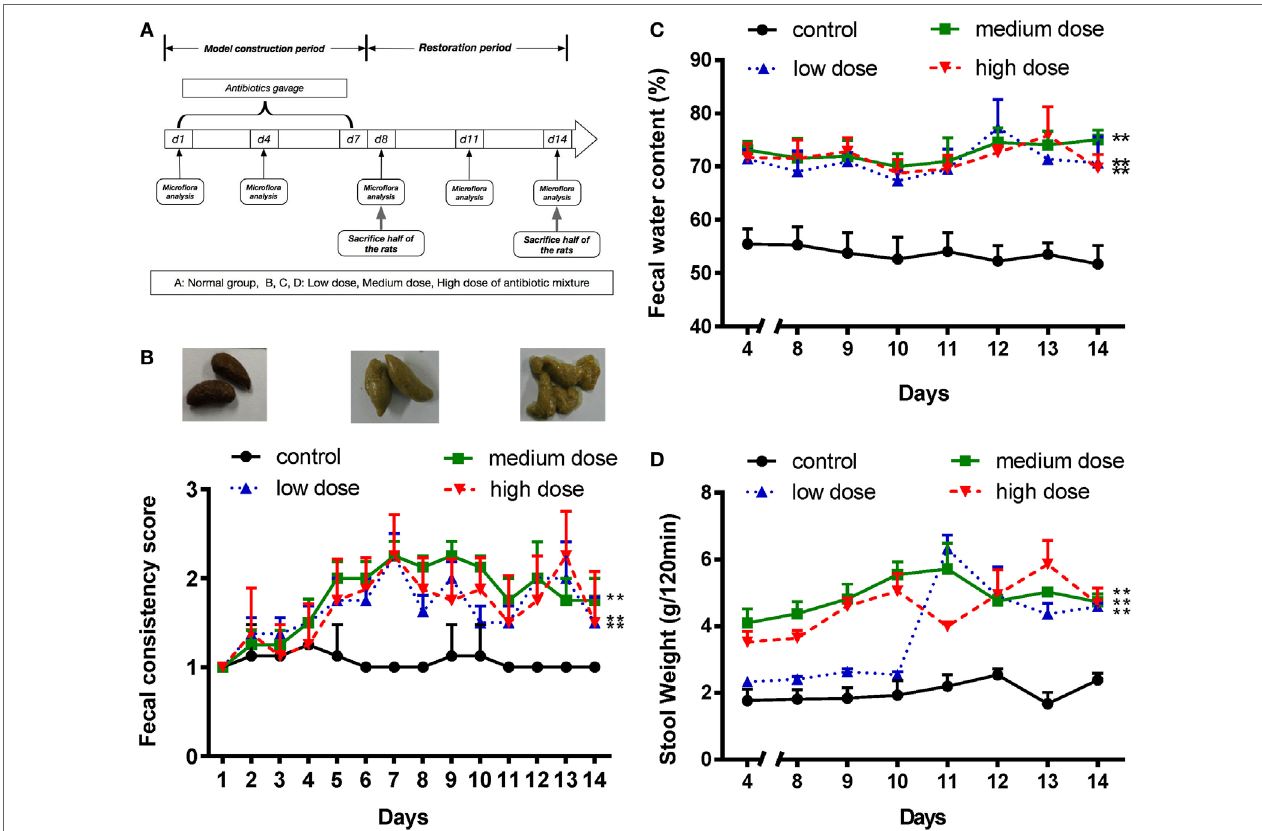
FigUre 1 | An appropriate mixture of antibiotics induces diarrhea in SD rats. (a) A schematic of antibiotic-associated diarrhea model. Rats were gavaged daily with antibiotics mixture for 7 days. (B) Fecal consistency was assessed and classified by three visual grading scale (upper panels), and fecal consistency scores were shown in all different groups (lower panel). (c,D) Fecal water content and 120-min stool weight were measured in rats treated with normal saline or different doses of antibiotic cocktails (low, medium, and high), from day 4 to day 14, n = 8/group. Repeated measures ANOVA, *P < 0.05 and ** P < 0.01 versus normal